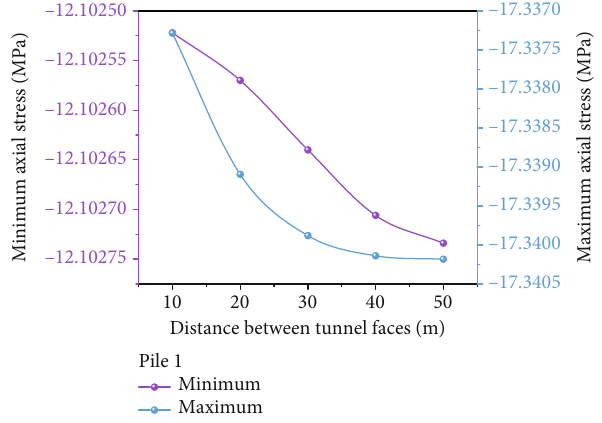
Figure 19: Maximum and minimum axial stresses of Pile 1 on completion of twin tunneling at di ff erent tunnel face-to-face distances.